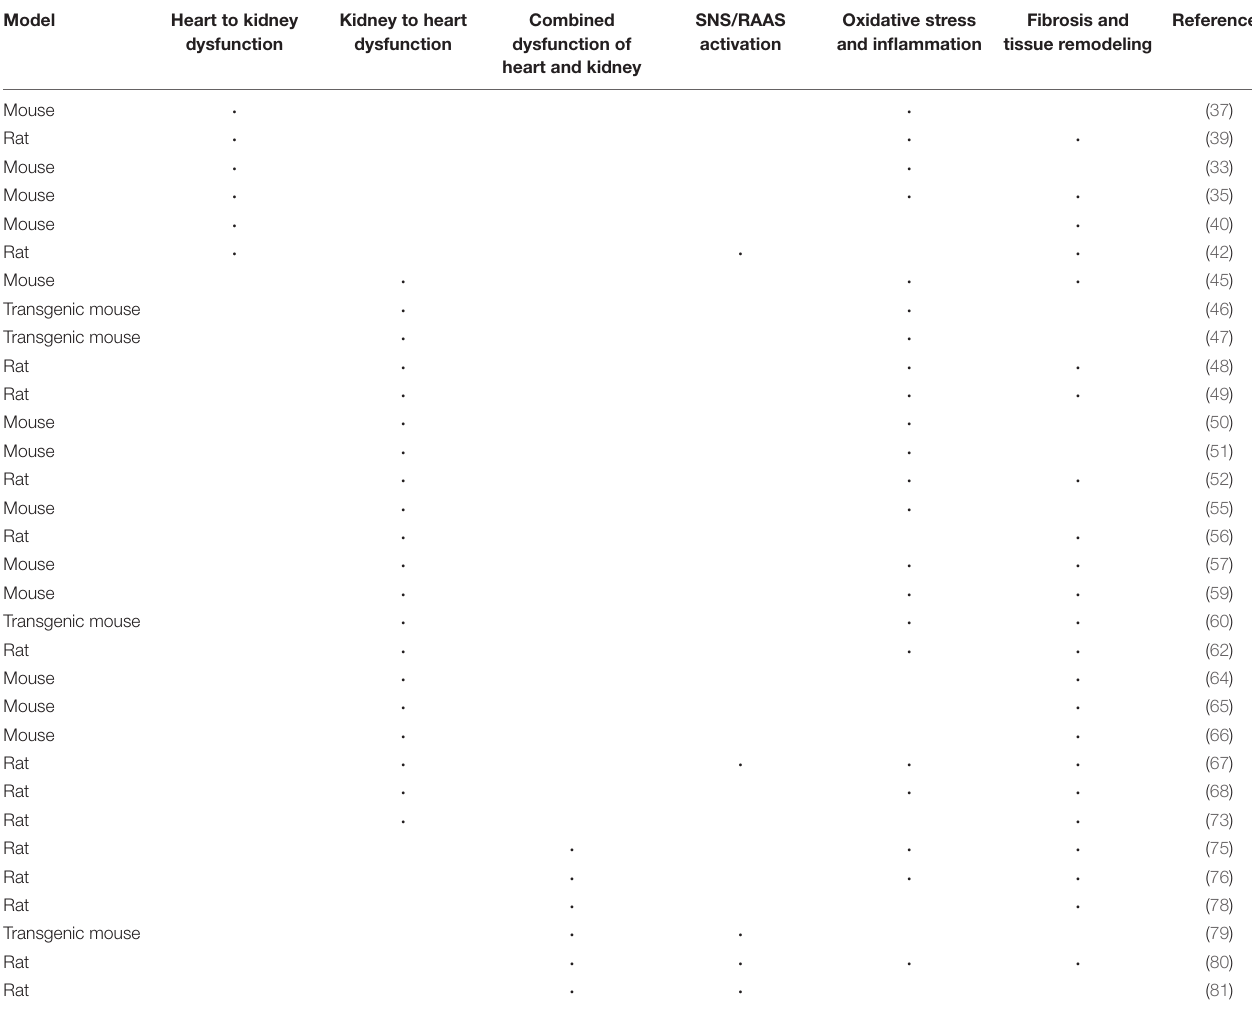
TABLE 2 | In vivo recapitulation of CRS